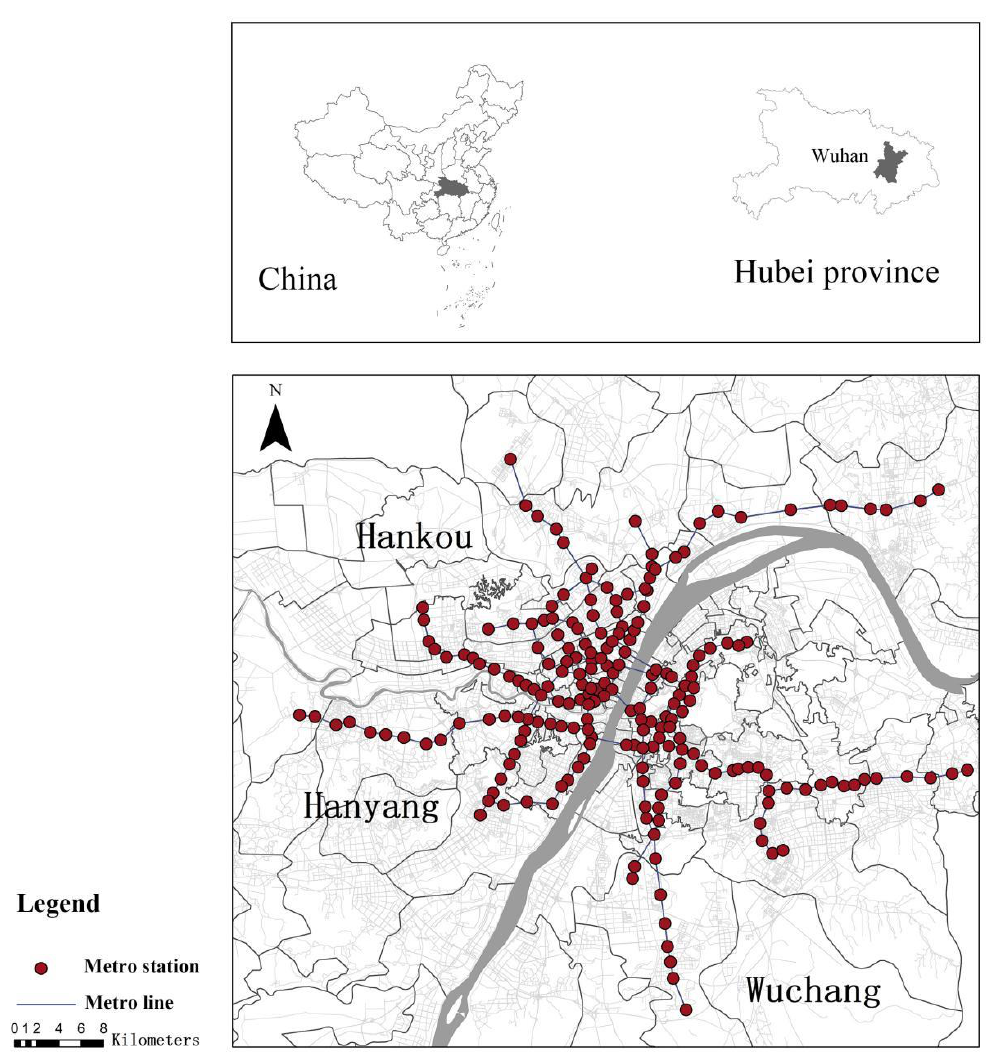
Figure 3. Map of the study area.